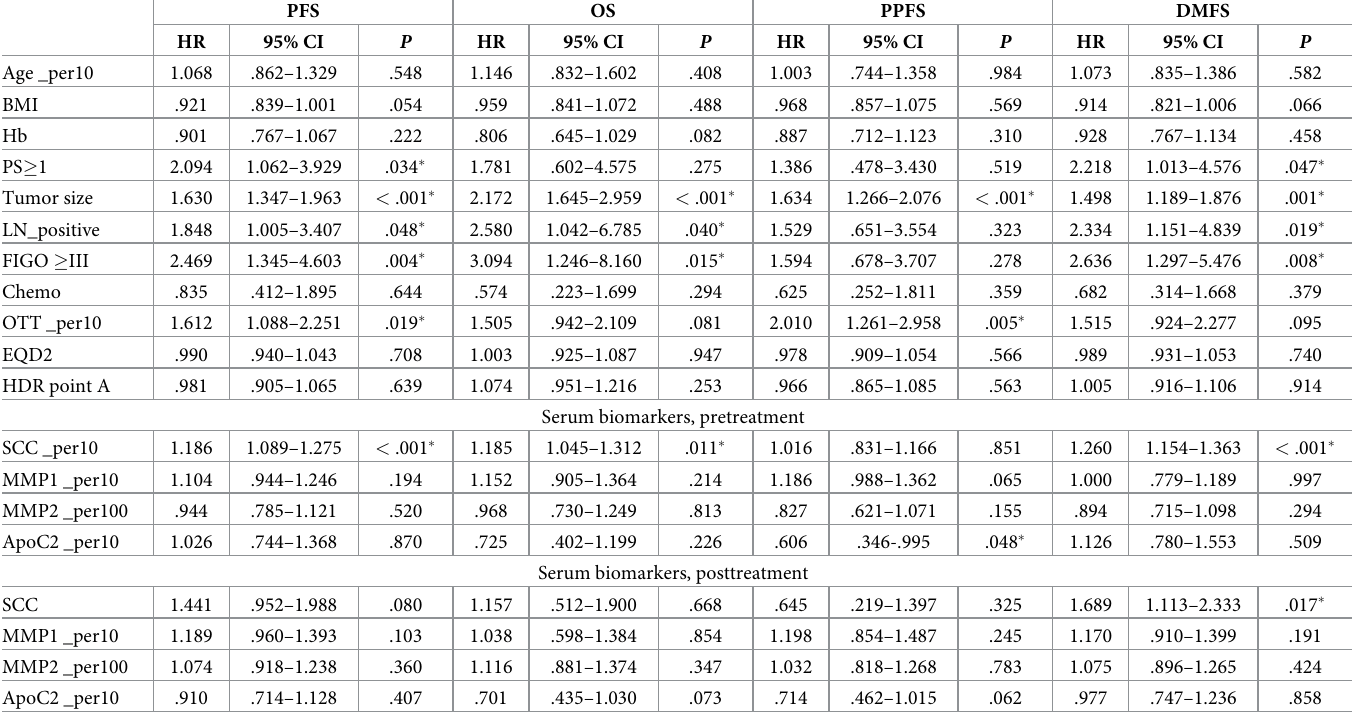
Table 2. Pre-and posttreatment biomarkers and clinical parameters Univariate analysis for PFS, OS, PPFS, and DMFS.